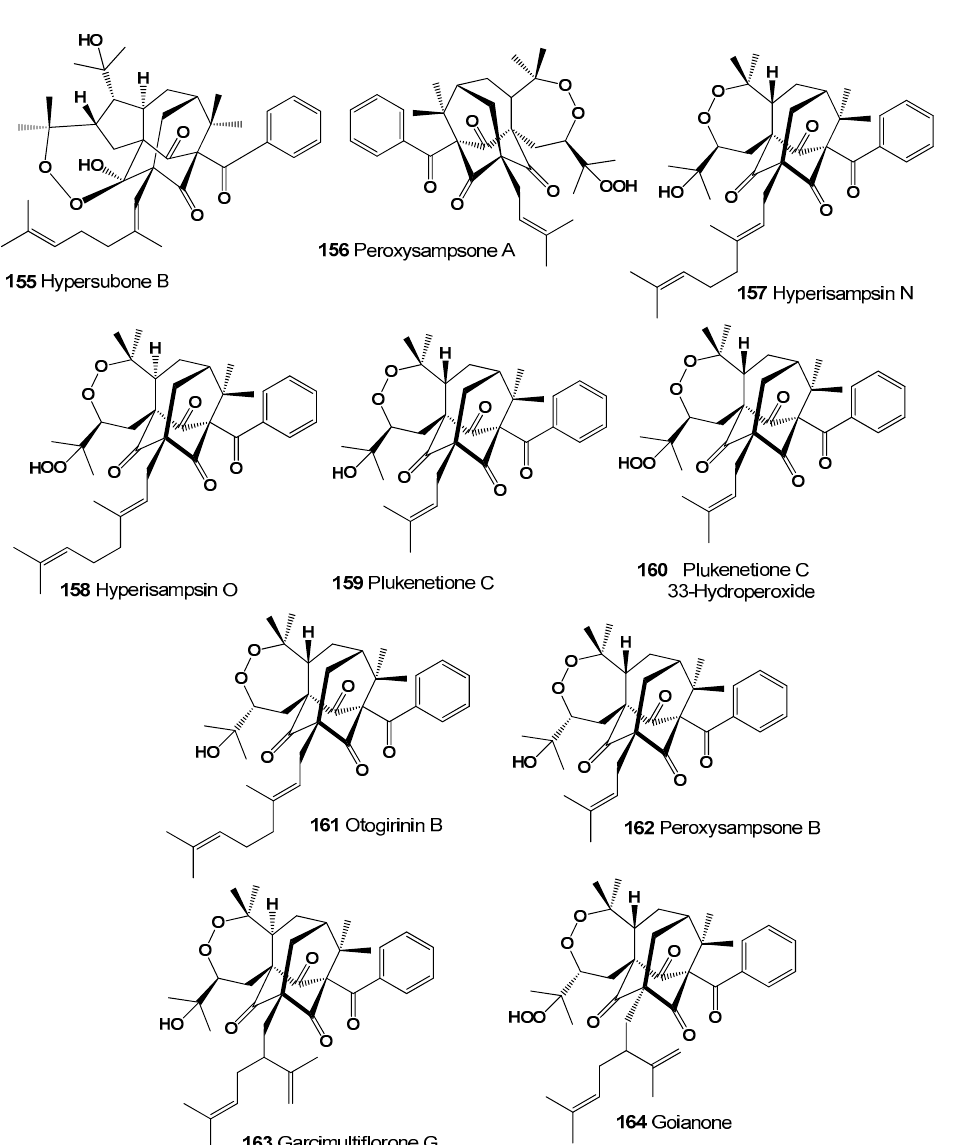
Figure 10. Bioactive adamantane type polycyclic endoperoxides derived from plants. Peroxysampsones A and B ( 156 and 162 ) were isolated from the roots of the Chinese medicinal plant H. sampsonii , and compound ( 156 ) showed comparable activity with norfloxacin against a NorA over-expressing multidrug-resistant strain of Staphylococcus aureus SA-1199B [243]. Two prenylated benzophenone derivatives, plukenetiones C ( 159 ) and hydroperoxide ( 160 ), have been isolated from the fruits of the Barbadian plant Clusia plukenetii [244], and otogirinin B ( 98 ) was detected in Hypericum erectum [245]. Garcimultiflorone G ( 163 ), which shows anti-inflammatory activity, was isolated from the fruits of Garcinia multiflora [246], and another polycyclic peroxide called goianone ( 164 ) was found in fruits extracts of Clusia rosea [247]. Unusual polycyclic endoperoxides pregnane glycosides named periplocosides A ( 165 ), B ( 166 ) C ( 167 ), D ( 168 ), K ( 169 ), F ( 170 ), and E ( 171 ) have been isolated from the antitu- mor fraction, which was obtained from the CHCl 3 extract of Periploca sepium [248–250]. Structures ( 165–171 ) can be seen in Figure 11, and their biological activity is presented in Table